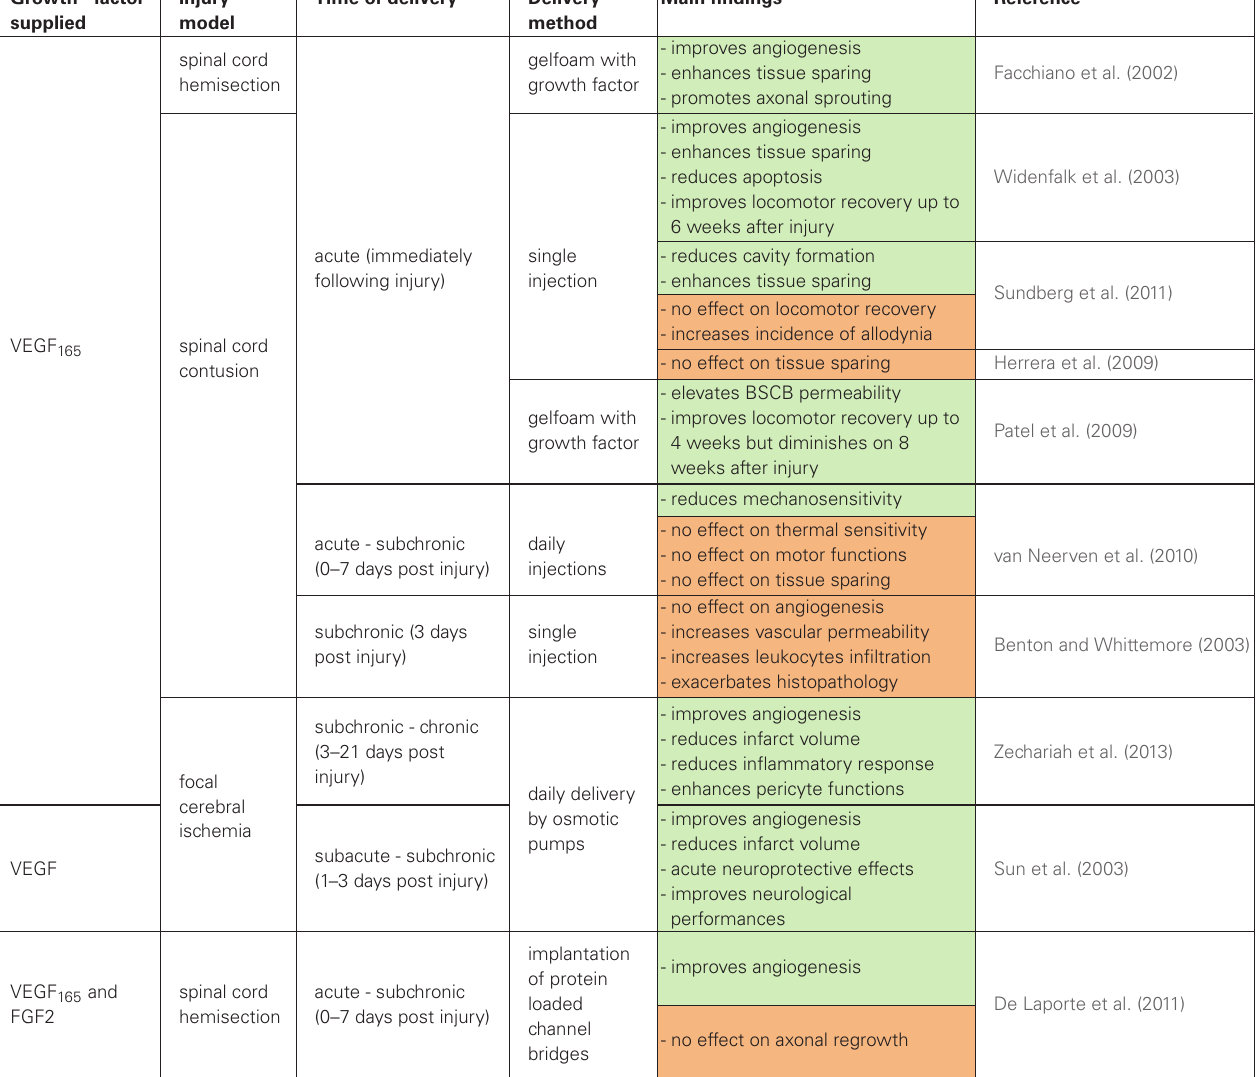
Table 1 | Summary of experimental studies that assessed the therapeutic angiogenic potential of VEGF after CNS trauma